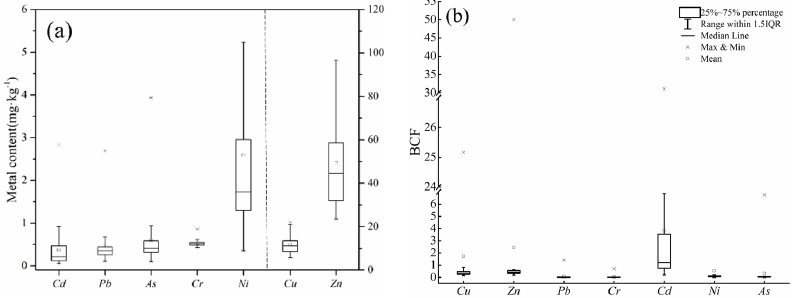
Figure 7. ( a ) Metal accumulation in vegetable samples and ( b ) bioconcentration factor (BCF) of dif- ferent metals. of different